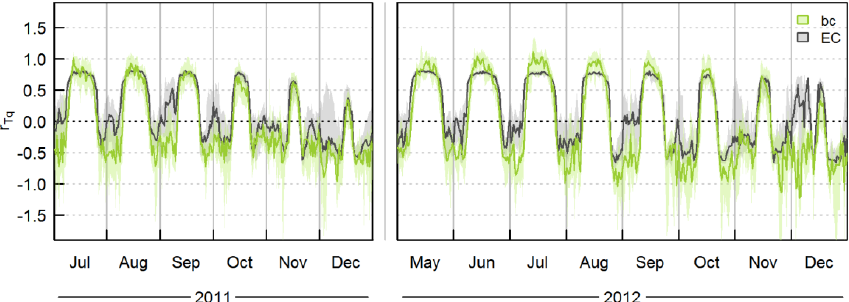
Figure 10. Monthly median diurnal cycles and inter-quartile ranges (shading) of the temperature–humidity correlation coefficient calculated from the BLS–MWS system via the bichromatic-correlation method and from